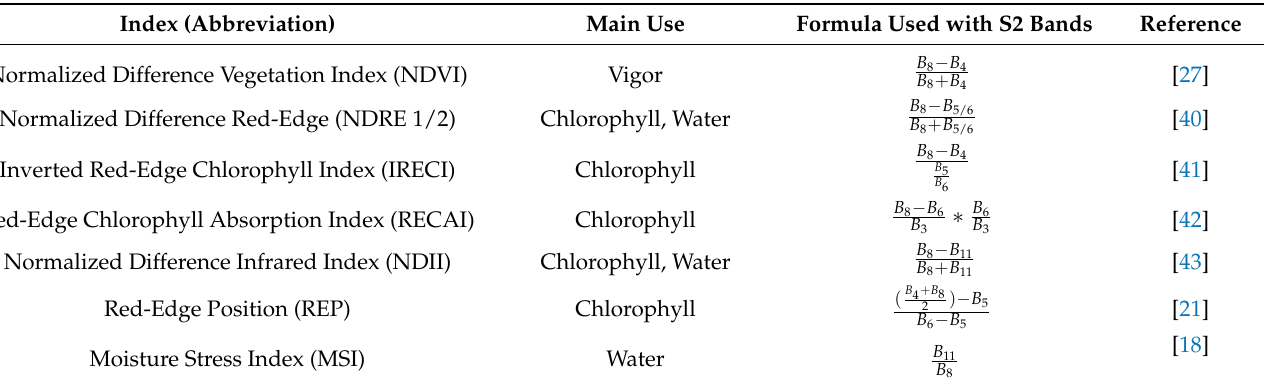
Table 5. Multispectral vegetation